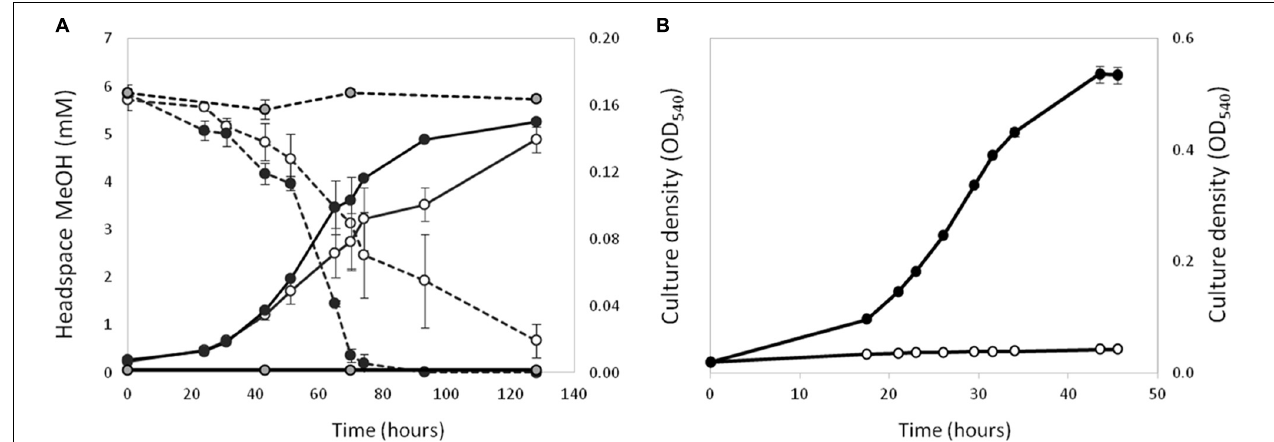
FIGURE 1 | Effect of the presence (black circles) or absence (white circles) of 5 µ M lanthanum on the growth (solid lines) of strain La 6 on methanol ( A , 5 mM initial concentration) and ethanol ( B , 5 mM initial concentration). Dotted lines represent headspace methanol concentrations. Gray circles are no-inoculum controls containing lanthanum. Error bars are the standard error of three